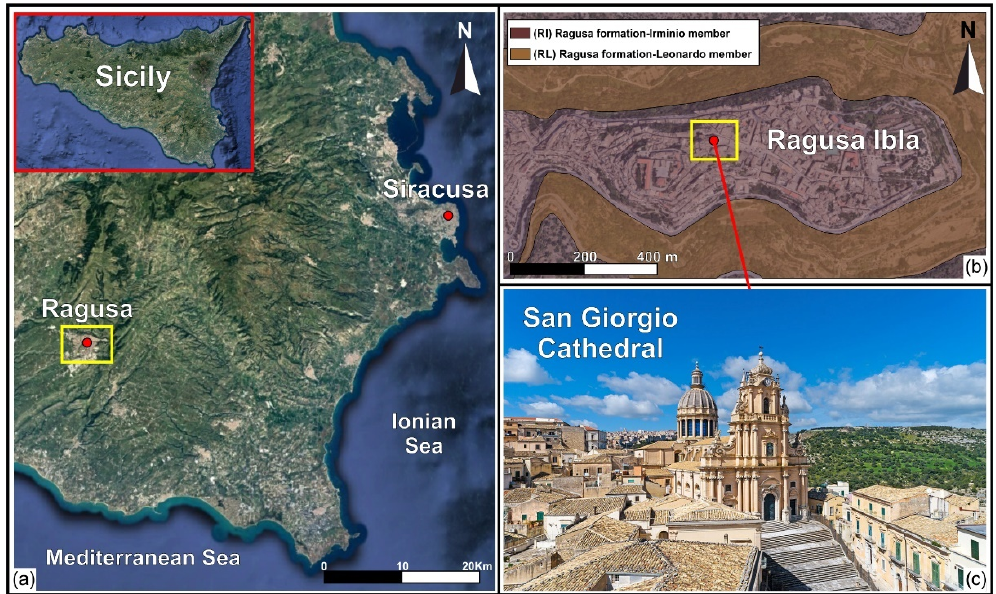
Figure 1. ( a ) Location of Ragusa Municipality (south-eastern Sicily); ( b ) geological map of Ragusa Ibla: RI Ragusa formation—Irminio member (white-grey calcarenites and calcirudites), RL Ragusa formation—Leonardo member (calcisiltites, marls and marly limestones); ( c ) External view of San Giorgio Cathedral.